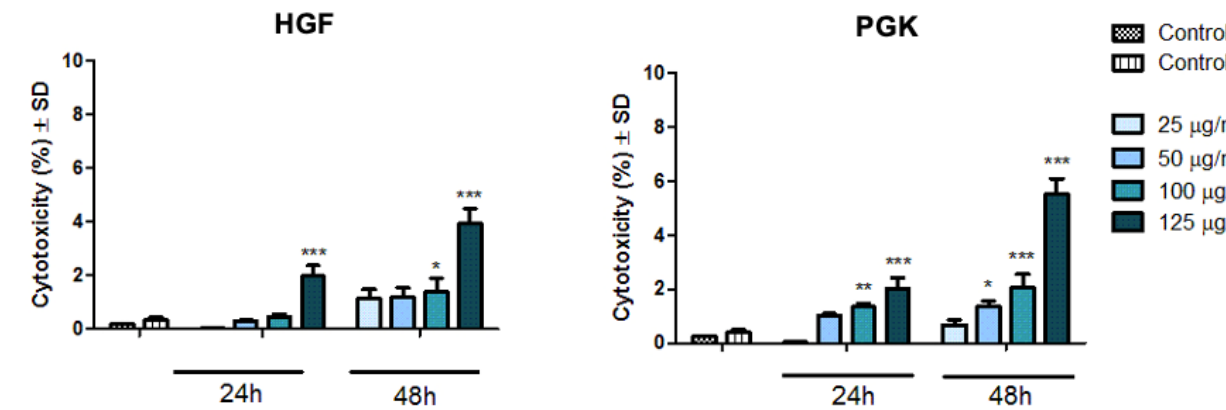
Figure 9. Cytotoxicity rate of primary human gingival fibroblasts (HGFs) and primary gingival keratinocytes (PGKs) at 24 h and 48 h post-treatment with Fe 3 O 4 @Carbon nanoparticles at concentrations of 25, 50, 100, 125 µg/mL. The results represent the mean values ± Standard Deviation (SD) of three individual experiments. One-way ANOVA test was performed to determine statistical differences of sample-treated cells compared to control cells, followed by Tukey’s multiple comparisons analysis (* p < 0.05; ** p < 0.01; *** p < 0.001 versus control cells).